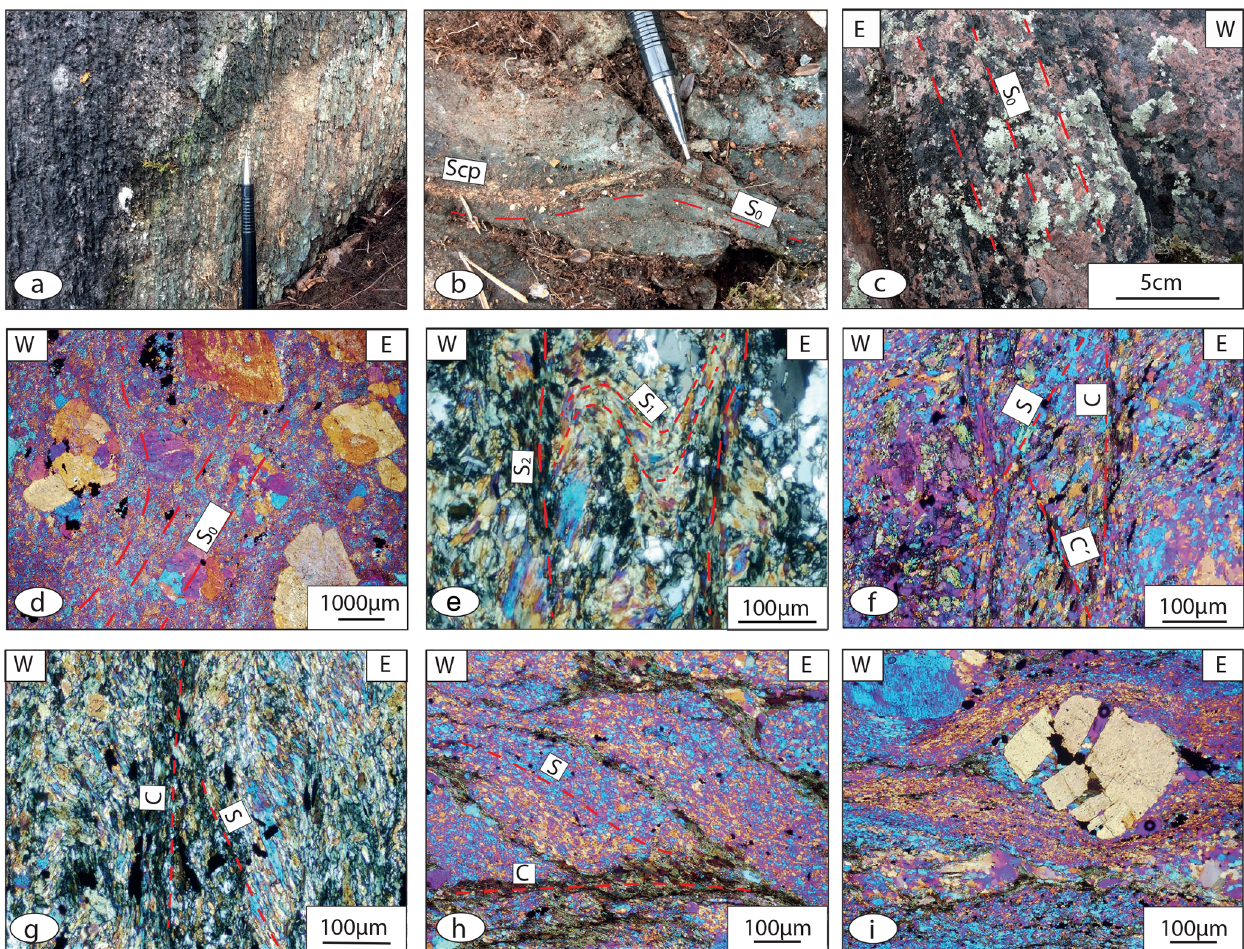
Figure 9. Field images and thin-section photographs of characteristics of the Ekströmsberg area. (a) Actinolite–tremolite L tectonite over- printed by calcite alteration, X689886 Y7530423. (b) Semi-conformable scapolite replacement of magmatic bedding in Rhyacian basalt, X688163 Y7530345. (c) Magmatic bedding in a felsic volcanic rock resembling a weak tectonic cleavage in outcrop, X691591 Y7527763. (d) Micrograph of the outcrop in (c) . (e) Micrograph of crenulation from same locality as (b) , X688163 Y7530345. (f) SCC (cid:48) fabric along north-plunging stretching lineation in the NNW-directed grain, X688714 Y7530350. (g) SC fabric along near-vertical stretching lineation